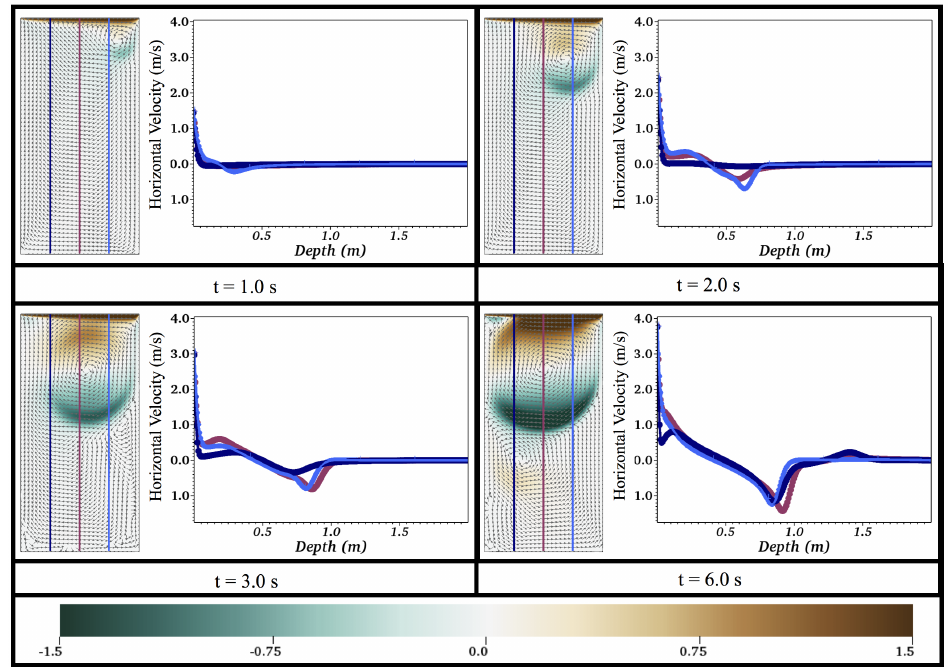
Figure 22. Snapshots of horizontal velocity measurements, when measured down the cavity in three places for Re = 4000.